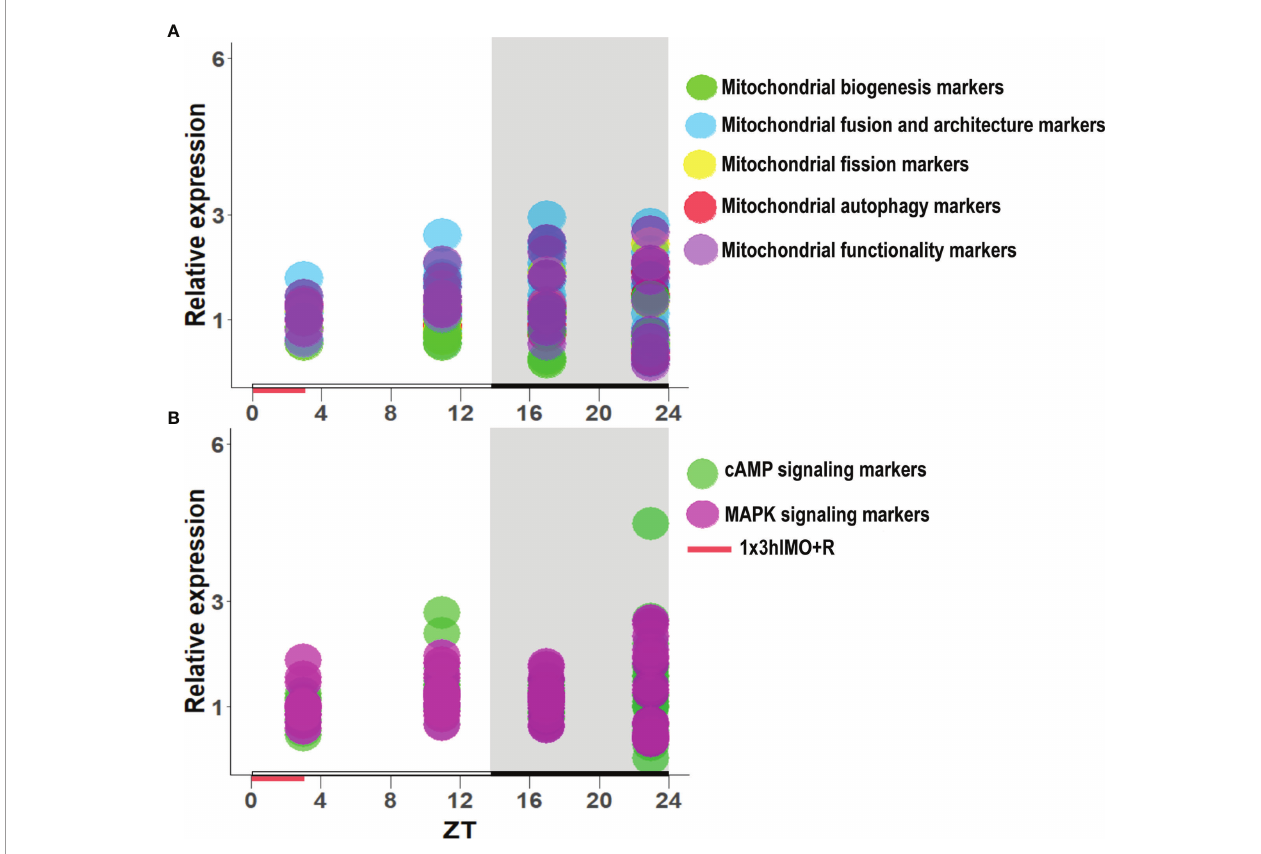
FIGURE 11 | The transcription pattern in spermatozoa of acutely stressed adult rats with different recovery periods (ZT3, ZT11, ZT17, and ZT23). Data shown represent the transcriptional pattern of the genes for mitochondrial dynamics/functionality markers (A) as well as cAMP and MAPK signaling pathway-related molecules (B) . Points represent a deviation in the transcription of a particular gene at different ZT time points.